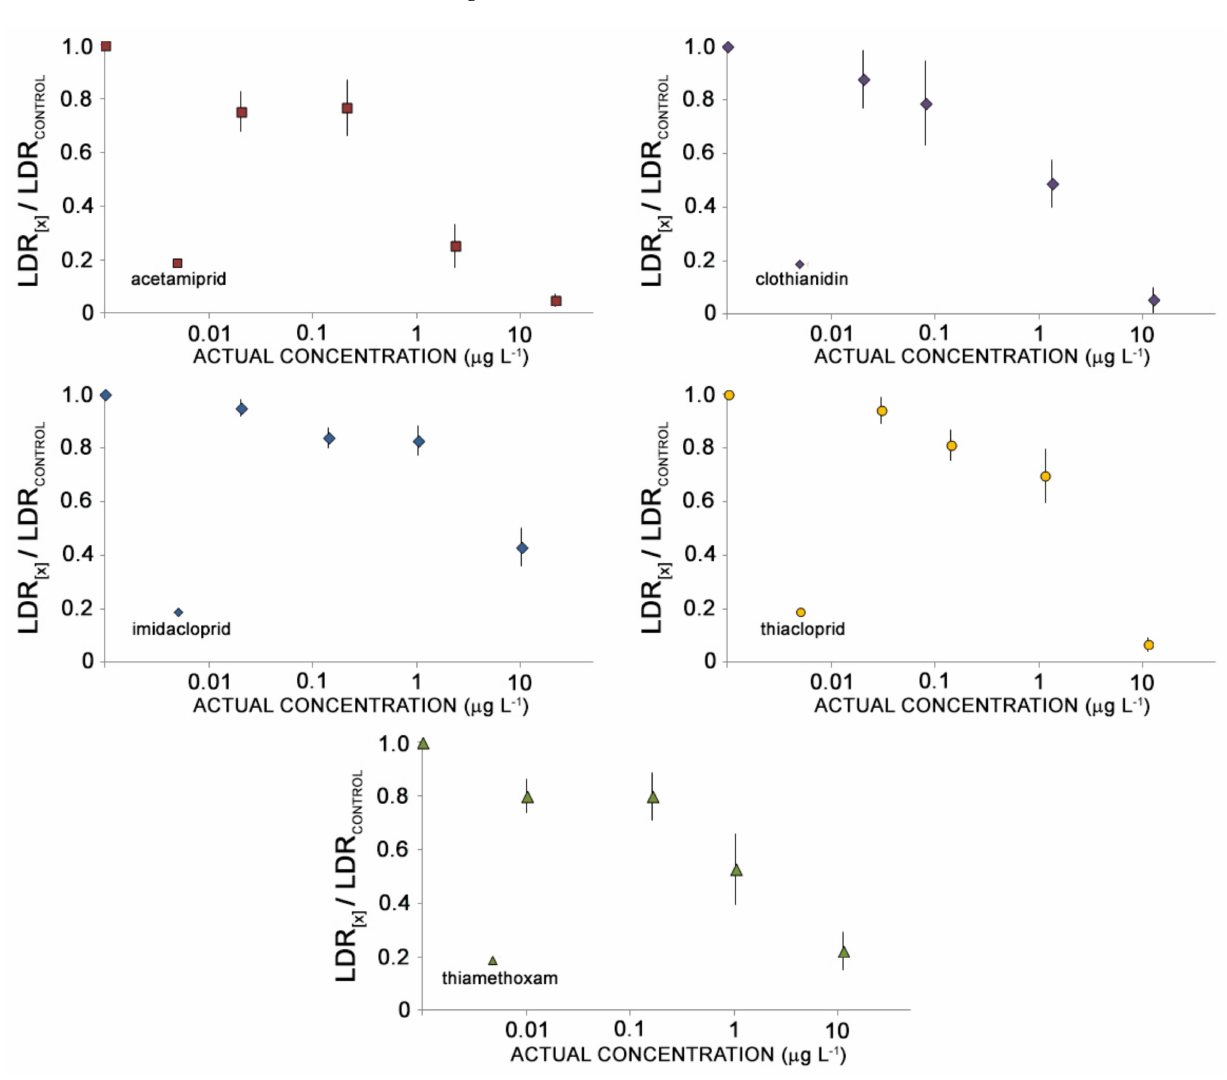
Figure 1. Concentration-effect curve for the tested NEOs. Larval development ratios (LDR x ) are reported as value normalized to negative control (LDR control ). Asterisks indicate treatment statistically different from negative control after one-way ANOVA and Dunnett’s post-hoc test ( p < 0.05). THI, CLO, and ACE inhibited almost completely the larval development of A.